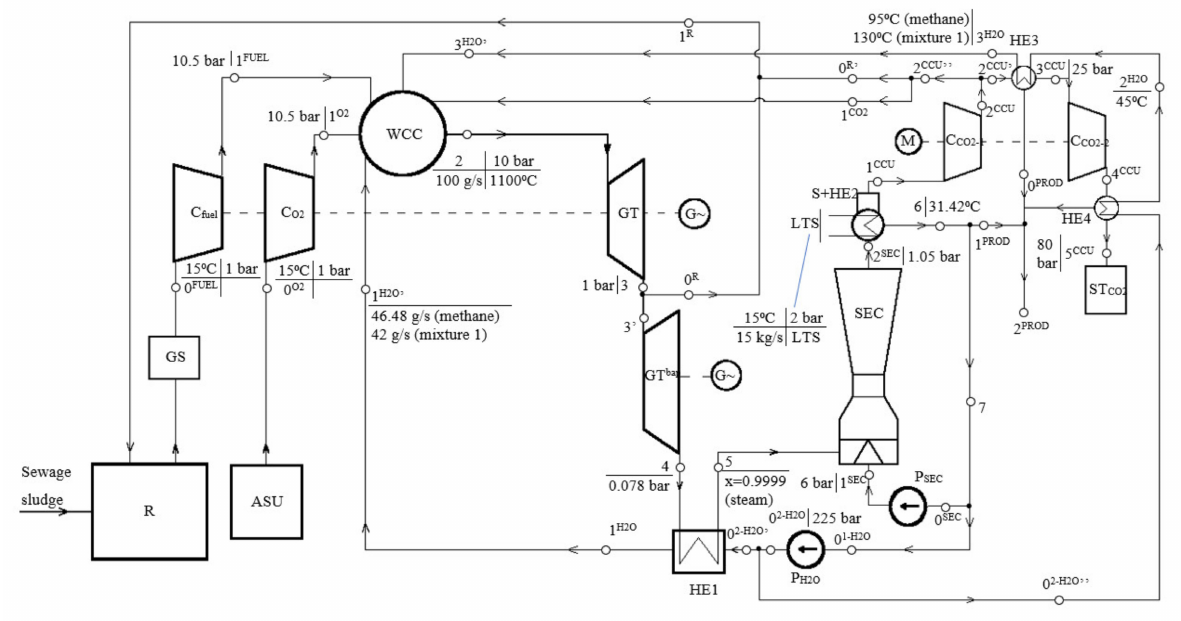
Figure 6. Process flow diagram of a gas mixture cycle—a steam-gas turbine system, where: WCC—wet combustion chamber; SEC—spray ejector condenser; R—gasifier (Reactor); GT—gas–steam turbine; GT bap —gas–steam turbine—below ambient pressure; C fuel —fuel compressor; C O —oxygen compressor; C CO —CO 2 capture unit compressors 1 and 2; P H —water 2 2 -1,2 2 O pump supplying supercritical water; P SEC —water pump supplying SEC, S + HE2—separator with heat exchanger 2; HE 1, 3, and 4—heat exchanger 1, 3, and 4; ASU—air separation unit; GS—gas scrubber; G~—power generators; M—motor; LTS—low-temperature source, ST CO —CO 2 storage tank. Nodal points—general thermodynamic cycle: 0 FUEL , 0 O 2 , 1 2 FUEL , 1 O 2 , 2, 3, 3’, 4, 5, 6, 7; optional: 2’; CO CCU , 2 CCU , 3 CCU , 4 CCU , 5 CCU ; optional: 2 CCU ’, 2 CCU ”; SEC: 2 capture unit: 1 0 SEC , 1 SEC , 2 SEC ; gasifying agent supply: 0 R ; optional: 0 R ’,1 R ; water production: 0 PROD , 1 PROD ’, 2 PROD ; optional CO 2 injection to WCC: 1 CO 2 ; water supply: 0 1-H 2 O , 0 2-H 2 O , 0 2-H 2 O ’, 0 2-H 2 O ”,1 H 2 O , 2 H 2 O , 3 H 2 O ; optional: 1 H 2 O ’, 1 H 2 O ”, 3 H 2 O